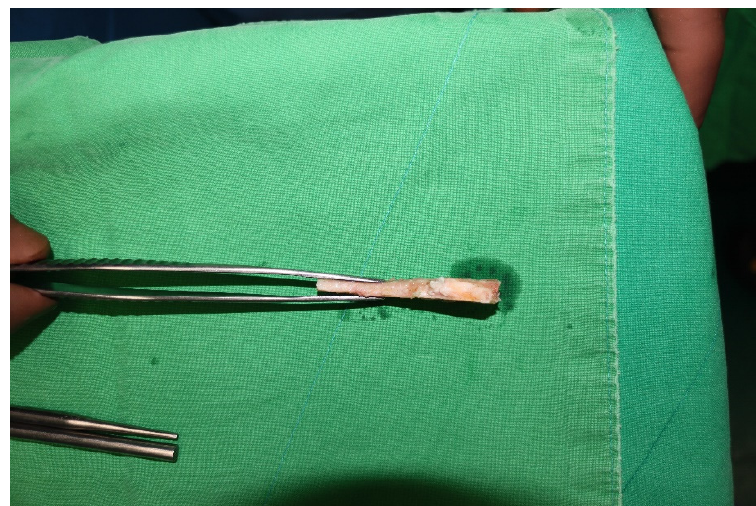
Figure 6. The resected fibular fragment was hemisected in the sagittal plane for use as a bone graft. The medial half was used as the filler of the arthrodesis site, and the lateral half was used as a lateral strut.